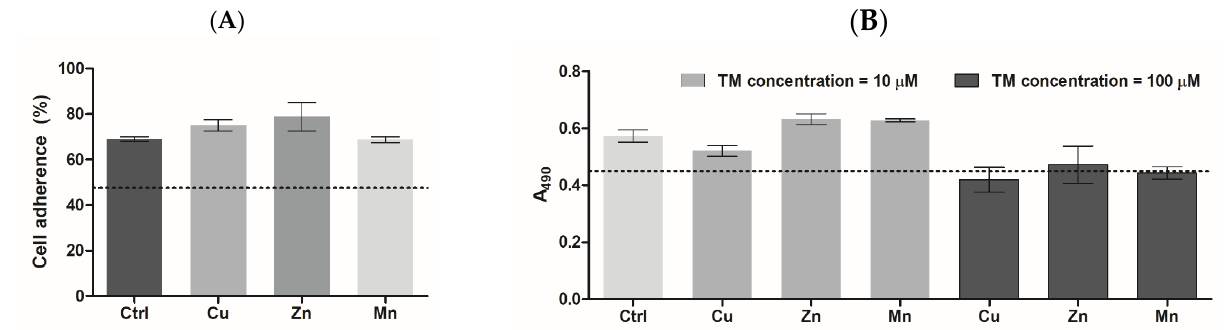
Figure 6. ( A ) Adherence of PC-12 cells on the surface of trace metal-modified PA matrices after 4 h incubation (% of the total cell number). ( B ) Viability of PC-12 cells cultured on trace metal-modified PA matrices (metal concentration was 10 or 100 µM), according to MTS test, 24 h post-seeding. The dotted line shows the cell adherence (%) ( A ) or cell viability signal ( B ) on the polystyrene surface of tissue culture plate.